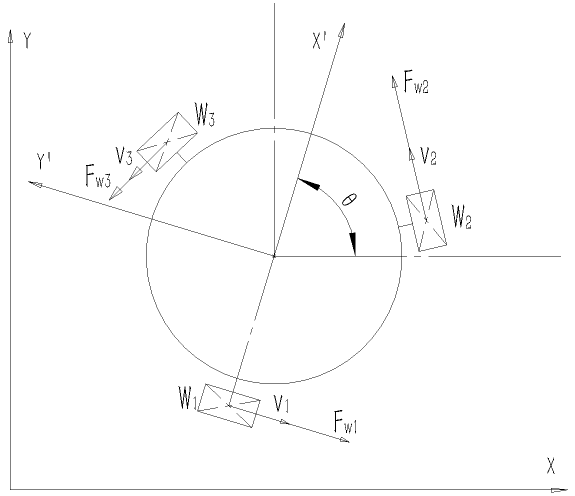
Figure 1. Schematic diagram of the three-wheeled omnidirectional robotic system.